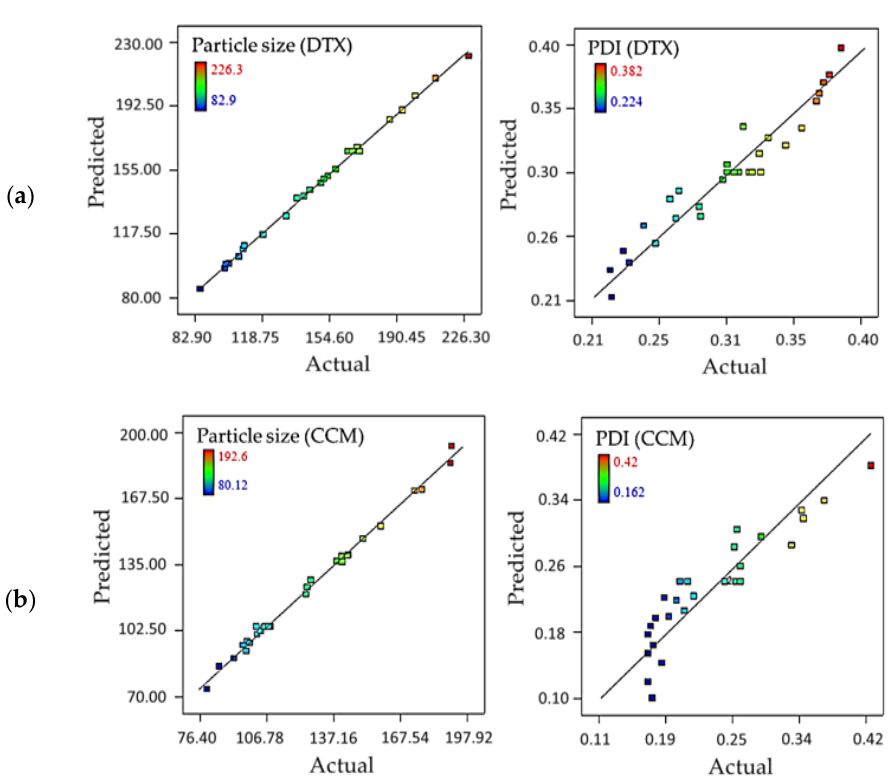
Figure 1. Scatter plot of predicted vs. actual particle size of ( a ) DTX-loaded nanoemulsion and ( b ) CCM-loaded nanoemulsion obtained from CCD experimental design. PDI: Polydispersity index.